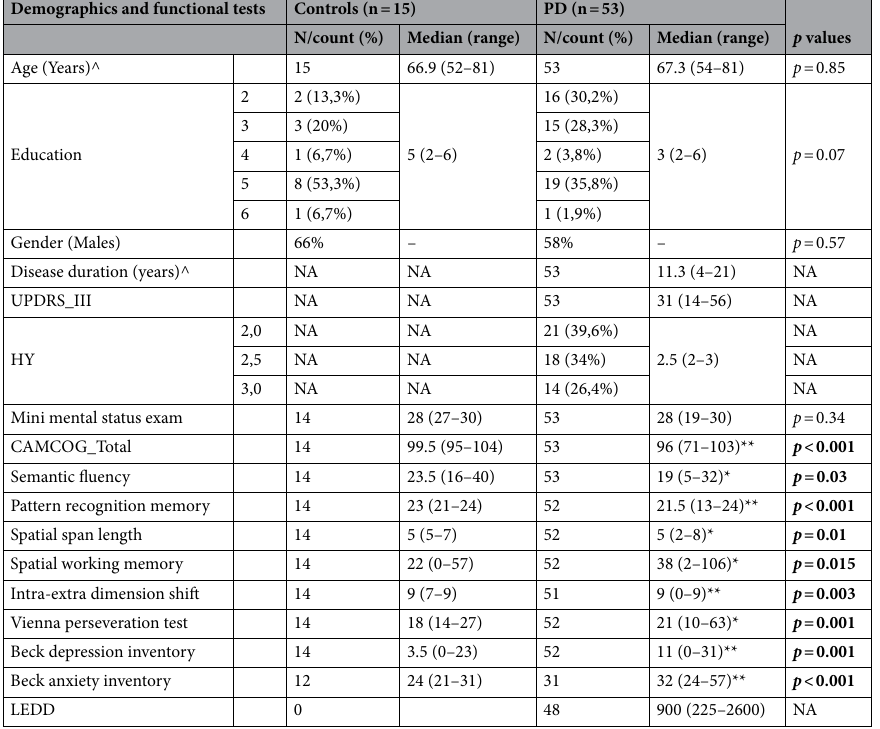
Table 1. Subject demographics and functional test scores. Education is based on ISCED system ranging from 0 to 6. CAMCOG_Total: Cambridge Cognitive Battery Total score, H&Y: Hoehn and Yahr stage, ISCED: International Standard Classification of Education, LEDD: Levodopa equivalent daily dose, PD: Parkinson’s disease, SD: Standard Deviation, UPDRS III: Unified Parkinson’s Disease Rating Scale part III, LEDD: L-DOPA equivalent daily dose.. ^mean and range is reported for these variables.. * p < 0.05, ** p < 0.01. Table adapted from Fathy et al., 2020 28